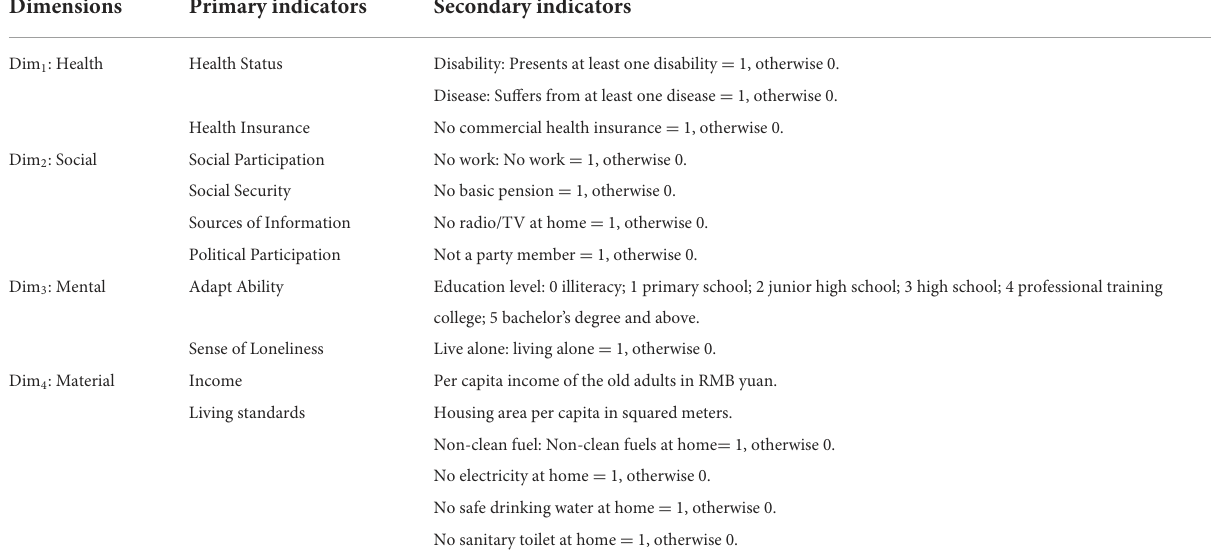
TABLE 2 Compositions of multidimensional poverty dimensions and indicators for older adults.